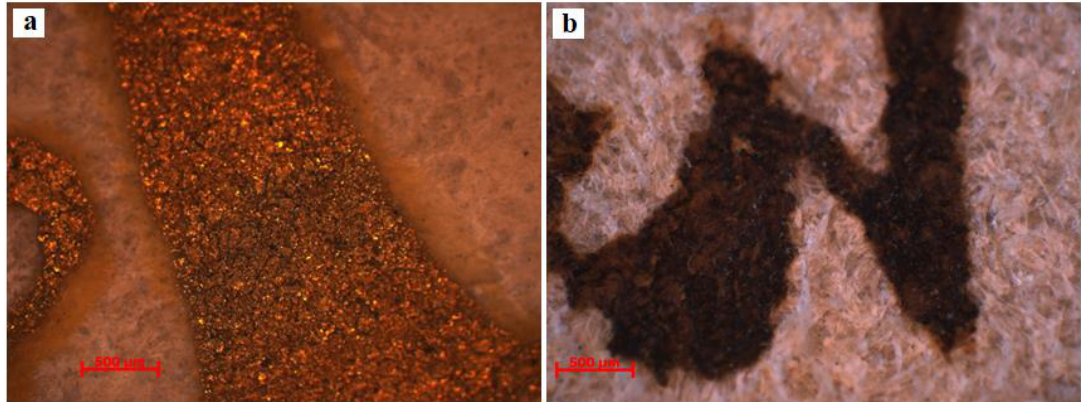
× 50) for the writing and miniature inks of document S2: ( a ) S2-CA; ( b ) S2-CN. Figure 6. OM images (×50) for the writing and miniature inks of document S2: ( a ) S2-CA; ( b ) S2-CN . Figure 6. OM images ( Both red and green ink (Figure 5a,b) present reticular fissures (cracks) and micro-lacunae